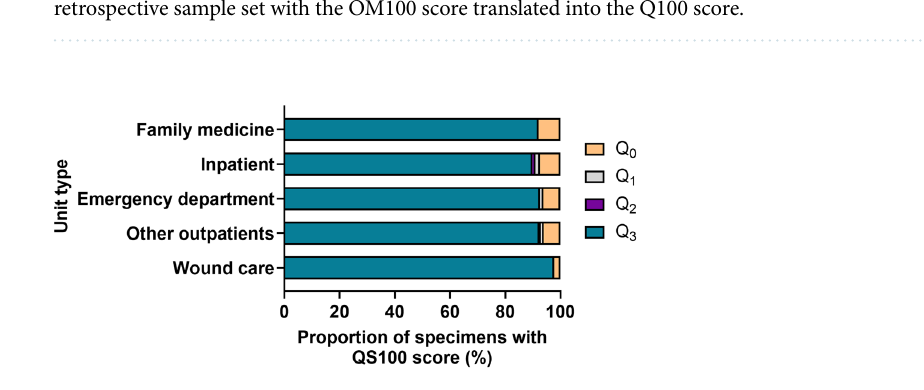
Figure 4. Examination of swab quality across different submitters within the hospital network. The number of in silico predicted Q 0 specimens submitted over the 390 day period was examined by units submitting swabs for routine culture. Submitters were classified as inpatient (including plastic surgery, general medicine, cardiovascular surgery, cardiology, among others) (N = 33/444, 7.43%), family medicine (N = 16/201, 7.96%), other outpatients (including hemodialysis, fracture clinic, gynecology, among others) (N = 12/212, 6.06%), emergency department (N = 5/81, 6.17%) or wound care (N = 1/44,